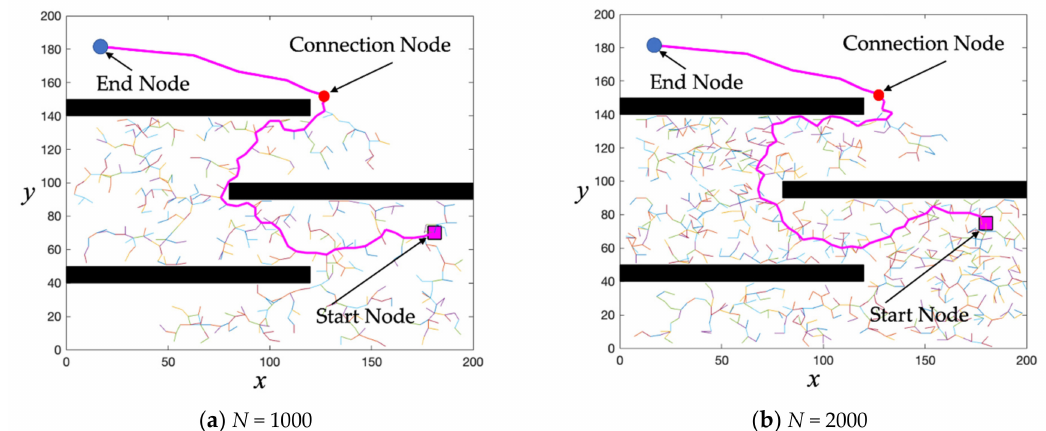
Figure 18. Assembly paths planned with different N of Case Study 2.